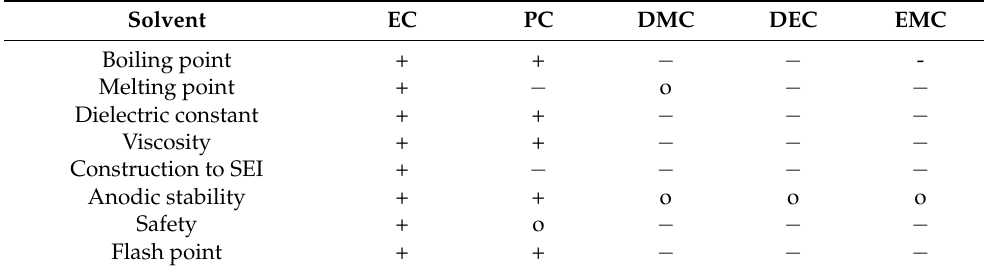
Table 2. A list of new solvents with their improved characteristics as compared to conventional solvent components, where +/ − means positive influence on the electrochemical system and negative and o means no